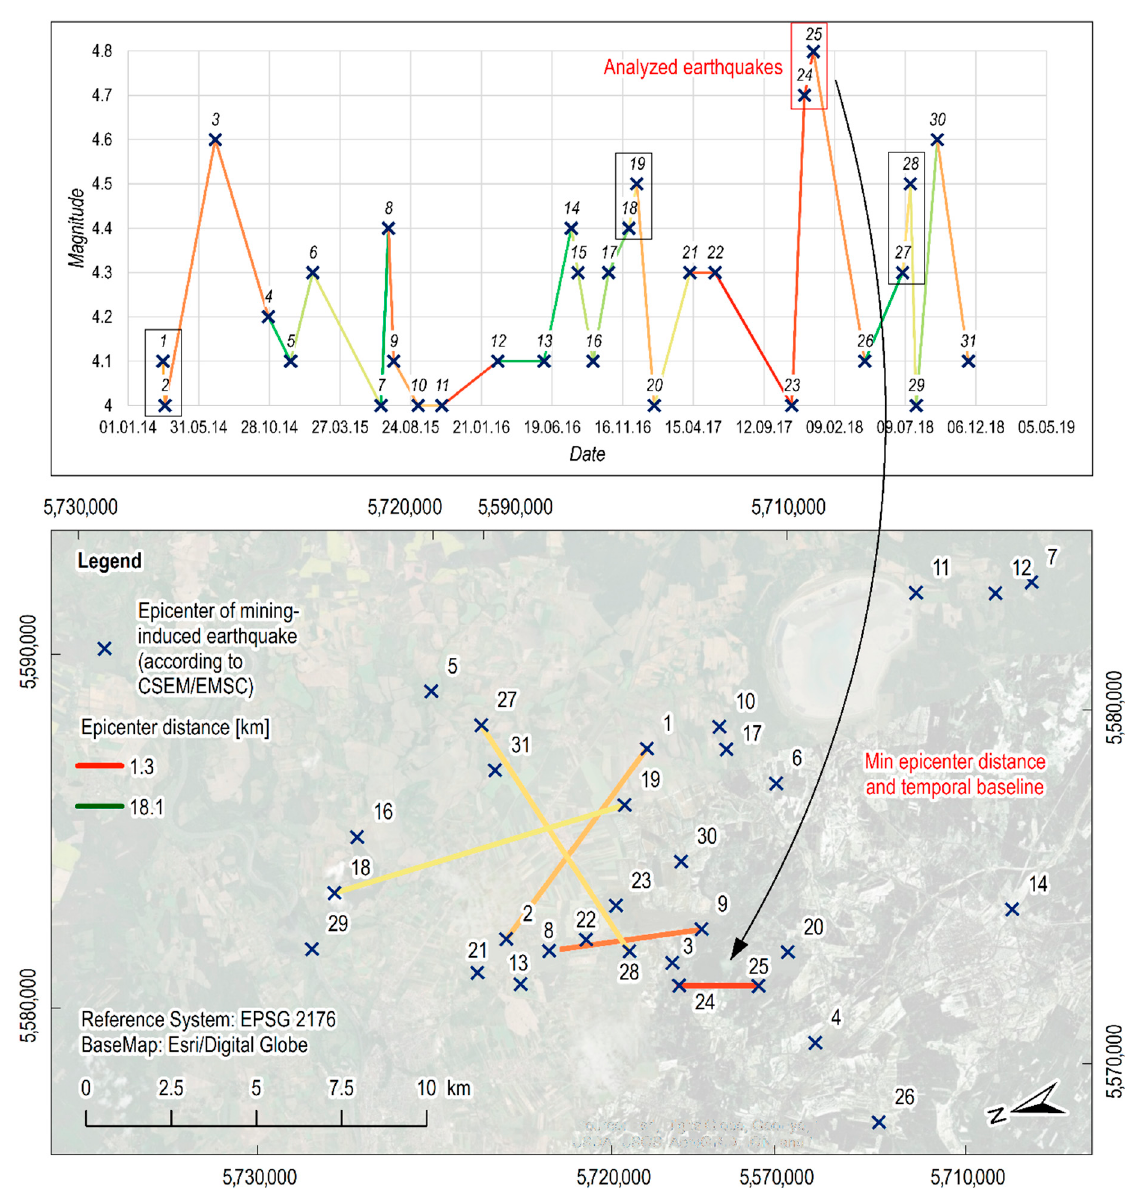
Figure 1. Spatial distribution of mining-induced tremor epicenters versus the time and magnitude of tremor occurrence. The investigated tremor base was indicated with an arrow.